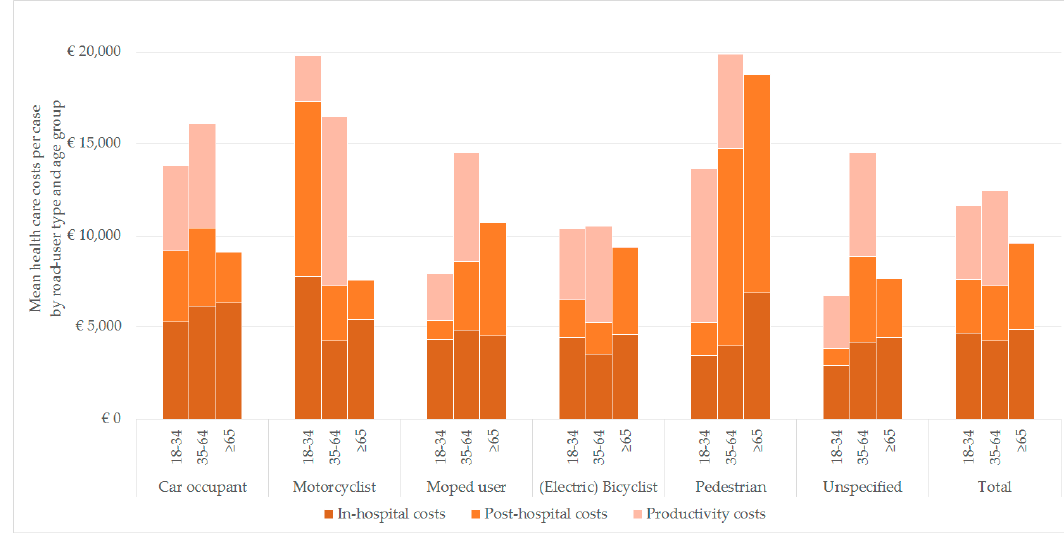
Figure 2. Mean health care costs by road user type and age group, 2017 EUR.